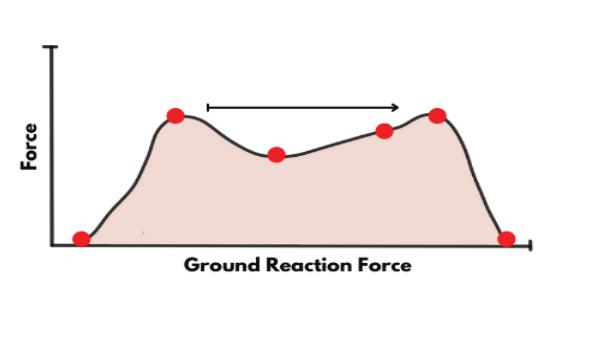
Figure-IX: A normal graph for ground reaction forces in the lower